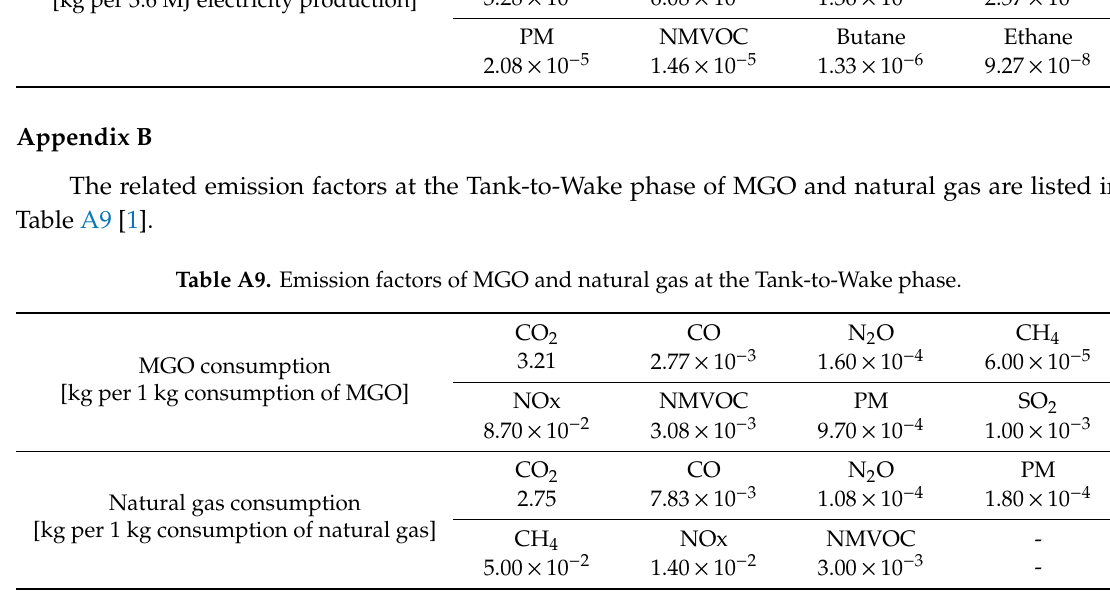
Emission factor from electricity in ROK